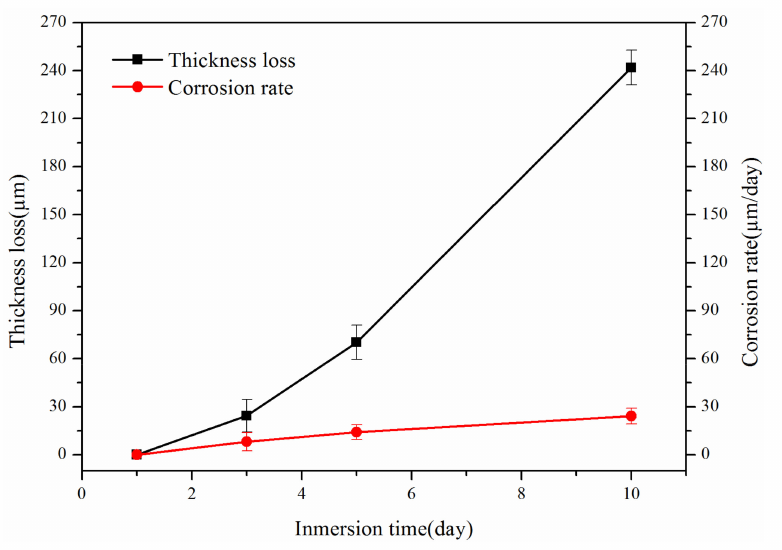
Figure 7. Corrosion resistance of FeB-30 wt.% Al 0.25 FeNiCoCr coating immersed in liquid zinc at 450 ◦